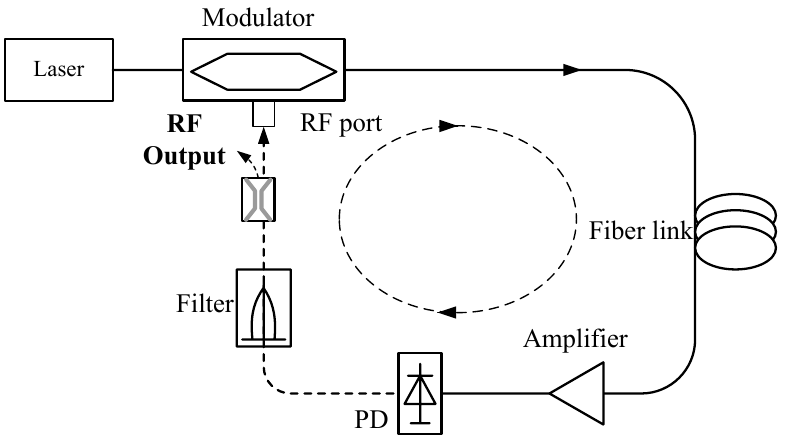
Figure 13. The schematic diagram of an optoelectronic microwave oscillator.